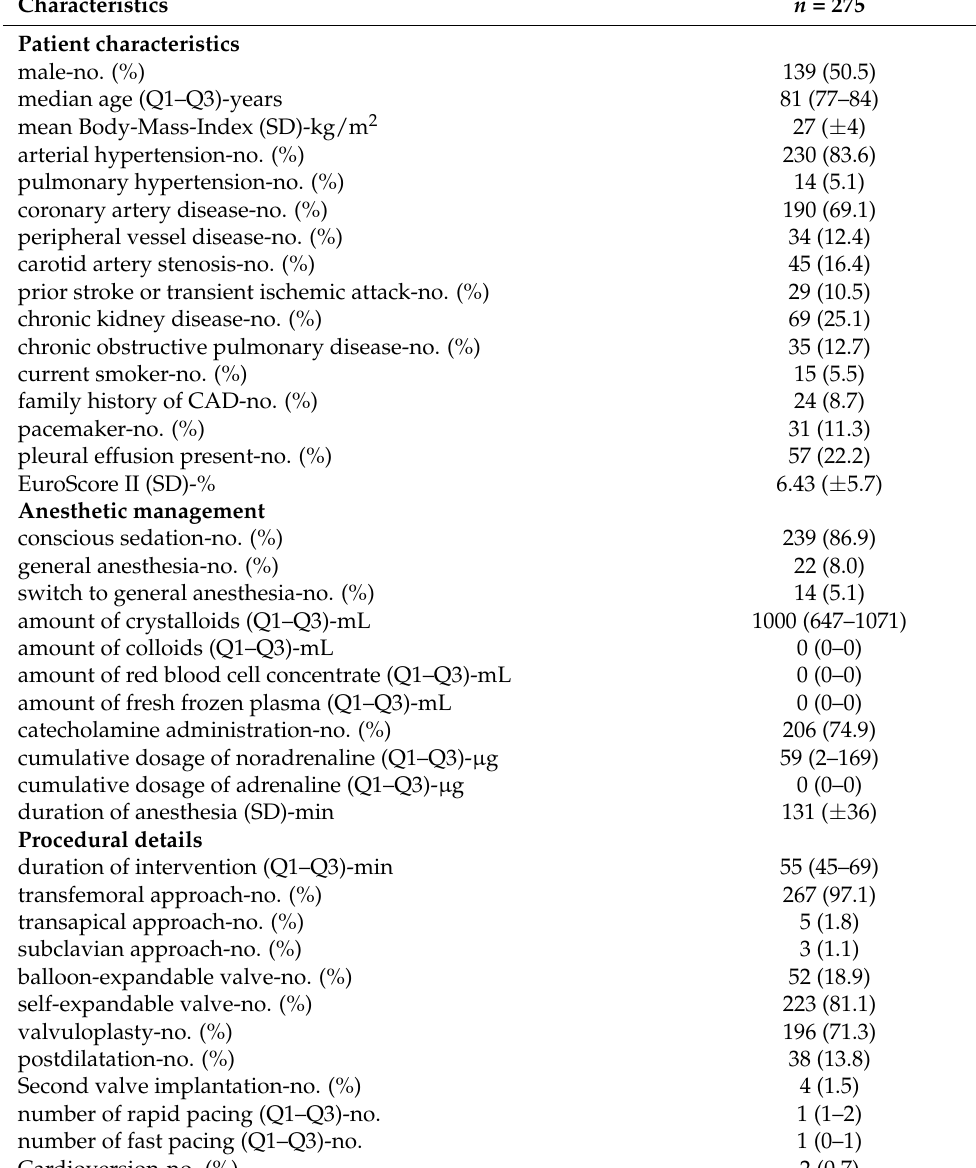
Table 1. Patient characteristics, anesthetic management, and procedural